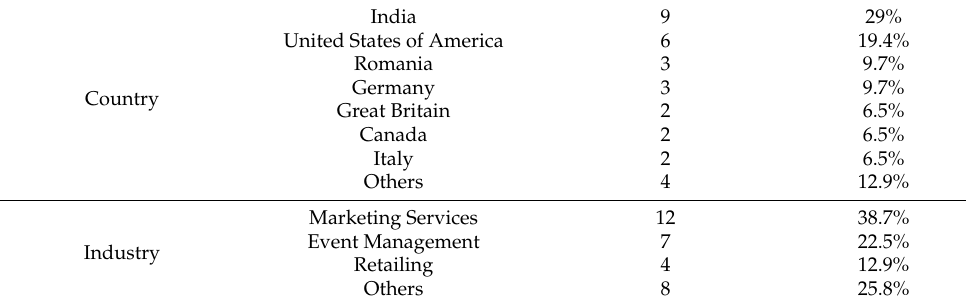
Table 1. Experts’ sample